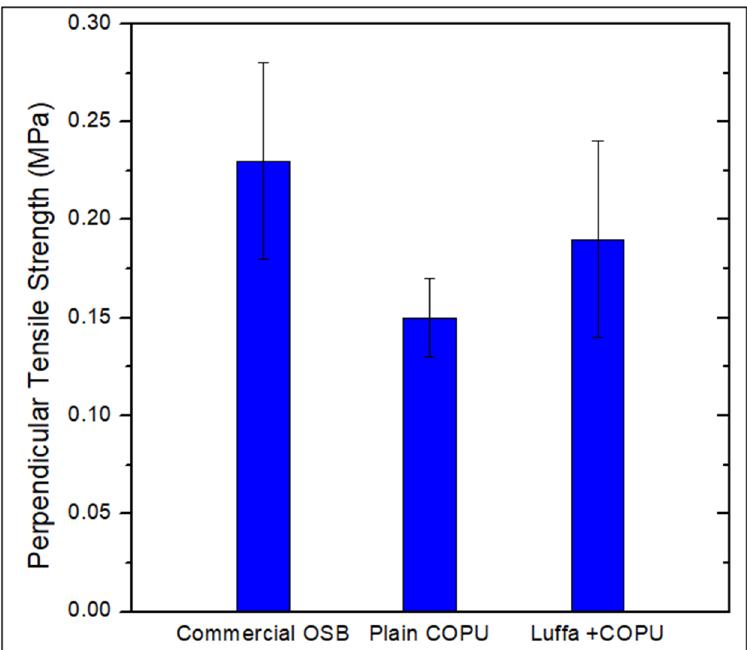
Figure 3. Perpendicular tensile testing results.